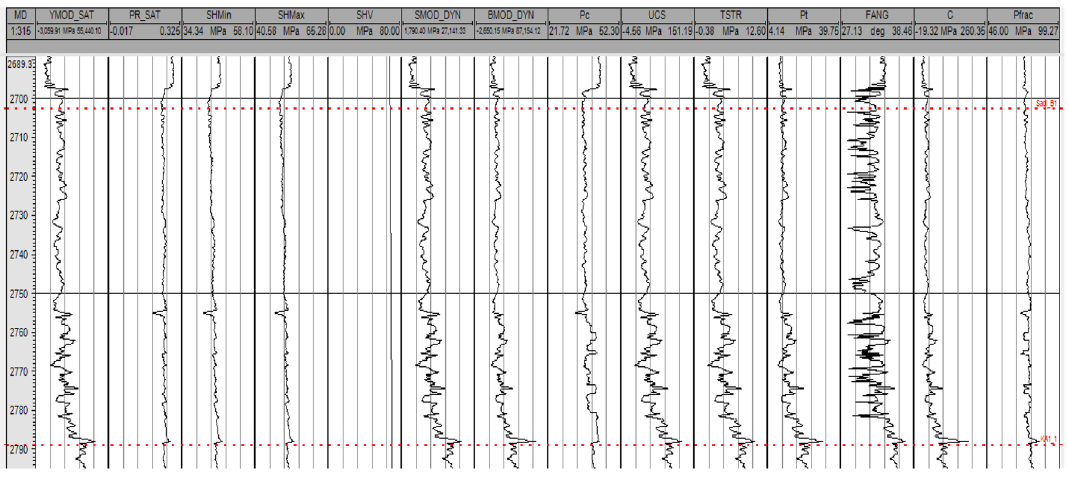
Fig. 10 One-dimensional rock mechanics parameters of well H5S